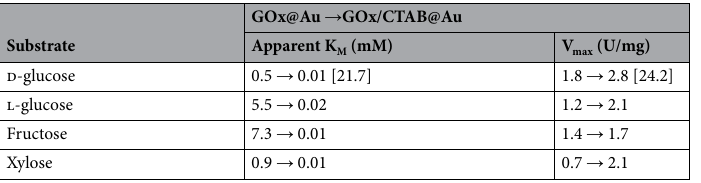
Table 2. The increase of activity of GOx towards monosaccharides by co-entrapment of CTAB. [In brackets are the K M and V max values for the free enzyme in solution 13 ].